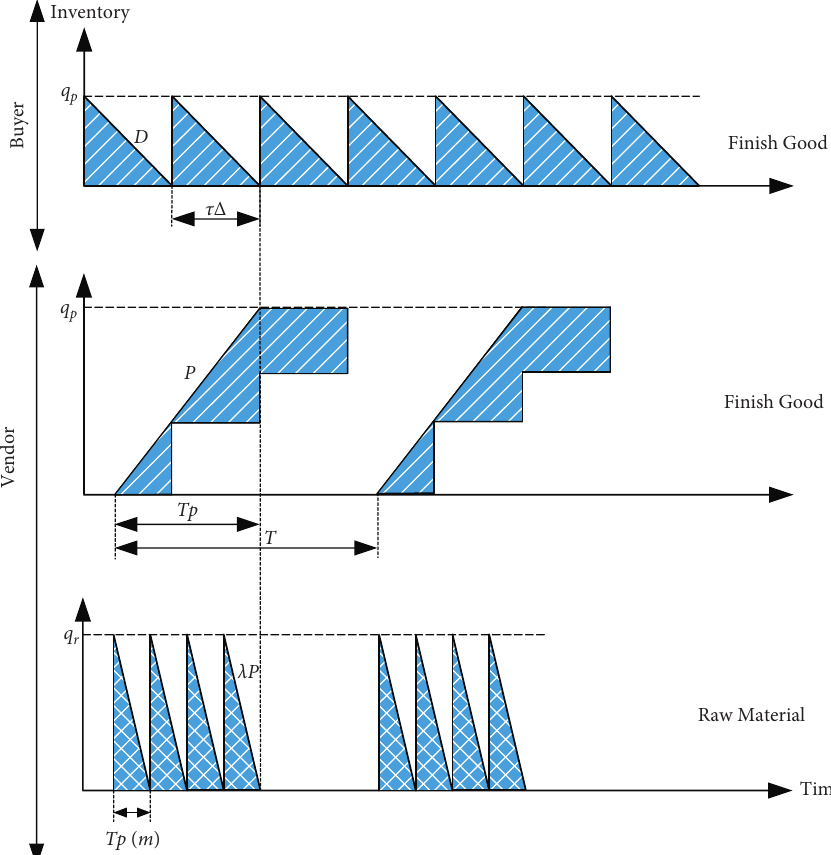
Figure 2: Inventory system on the